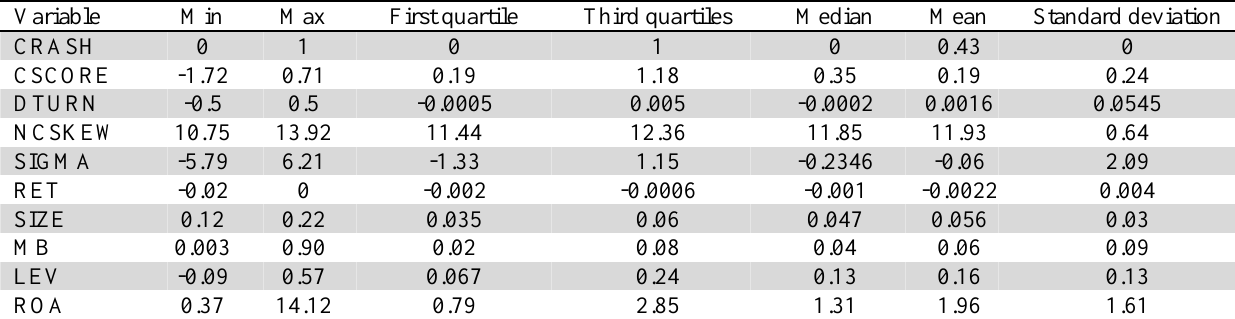
The summary of basic statistics on